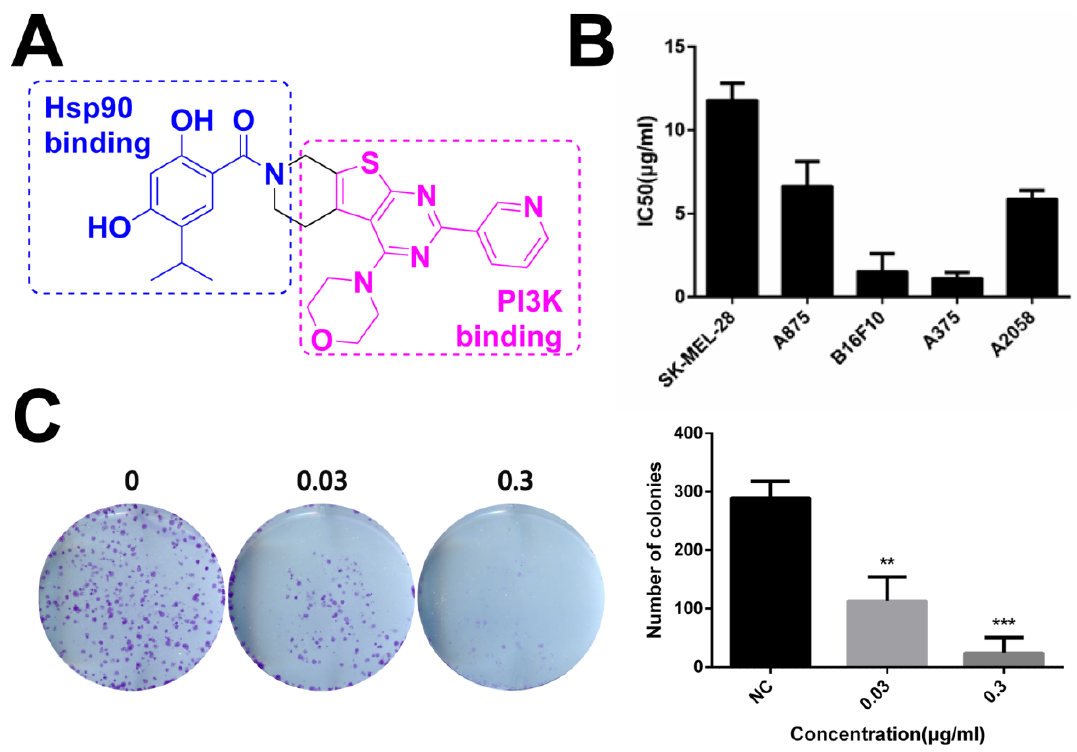
Figure 1. DHP1808 suppresses skin melanoma cell proliferation and clonogenic potential. ( A ) Chemical structure of dual inhibitor DHP1808; ( B ) Cells were incubated with various concentrations (1.25, 2.5, 5, 10, 20 or 40 μ g/mL) of DHP1808 for 24 h. Mean IC 50 values of DHP1808 against five melanoma cell lines after 24 h incubation; ( C ) Cells were incubated with various concentrations (0.03 or 0.3 μ g/mL) of DHP1808 for 5 days. DHP1808 potently inhibited colony formation. ** p < 0.01, *** p < 0.001 versus the control group.